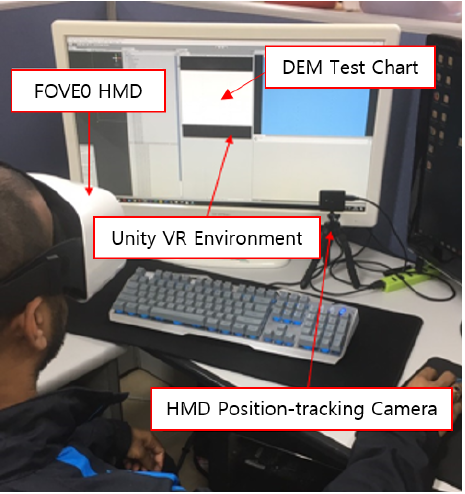
Figure 4. The experimental environment of the proposed